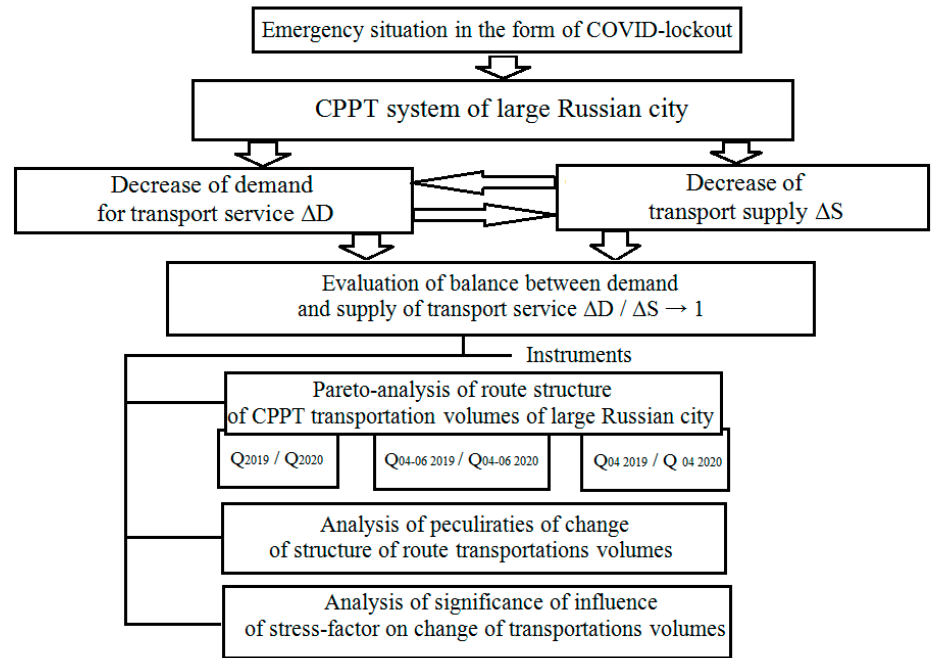
Figure 12. Scheme of evaluation of the impact of COVID-lockdown on the system of a large city passenger transportation.